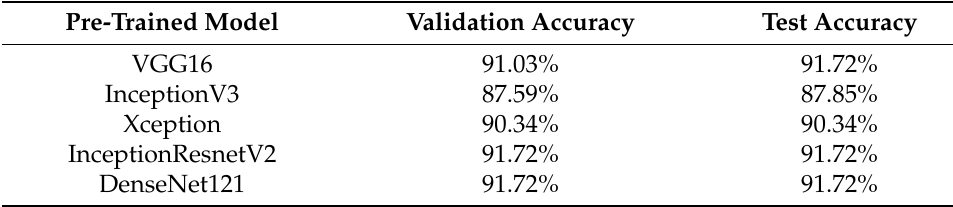
Table 3. Pre-trained model results without data augmentation.